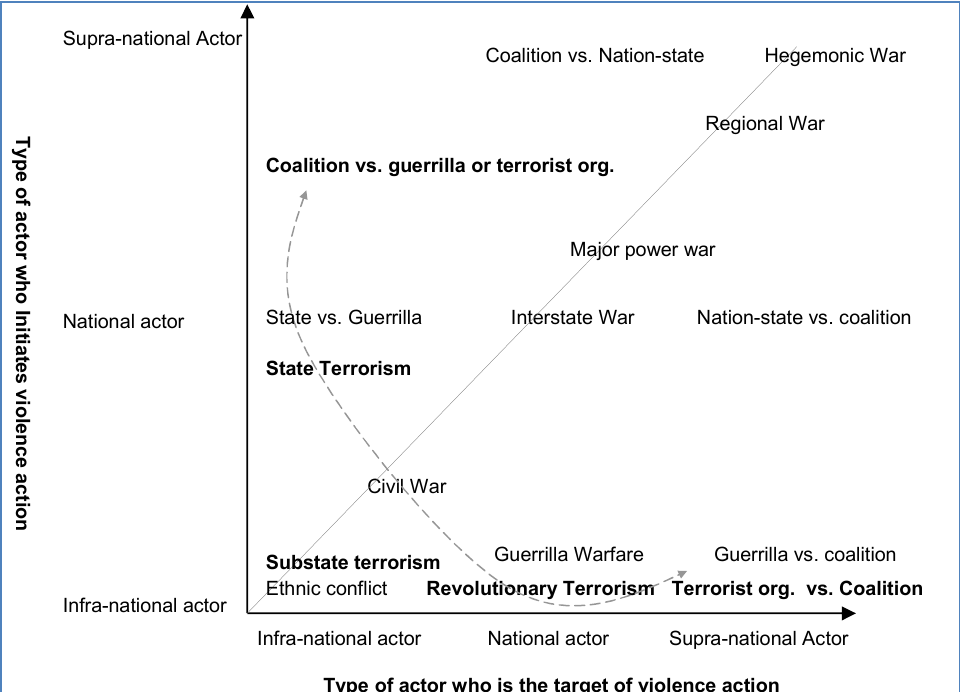
Figure 1: Forms of Violent Interaction by Type of Actor in the Interstate